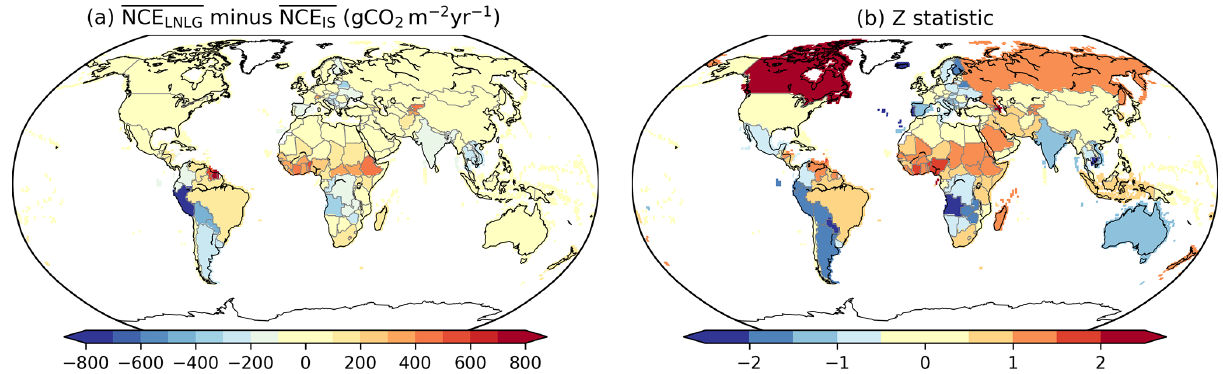
Figure 8. Difference between LNLG and IS experiments. (a) NCE LNLG minus NCE IS and (b) the Z statistic (Eq. 7) indicating the difference between LNLG and IS